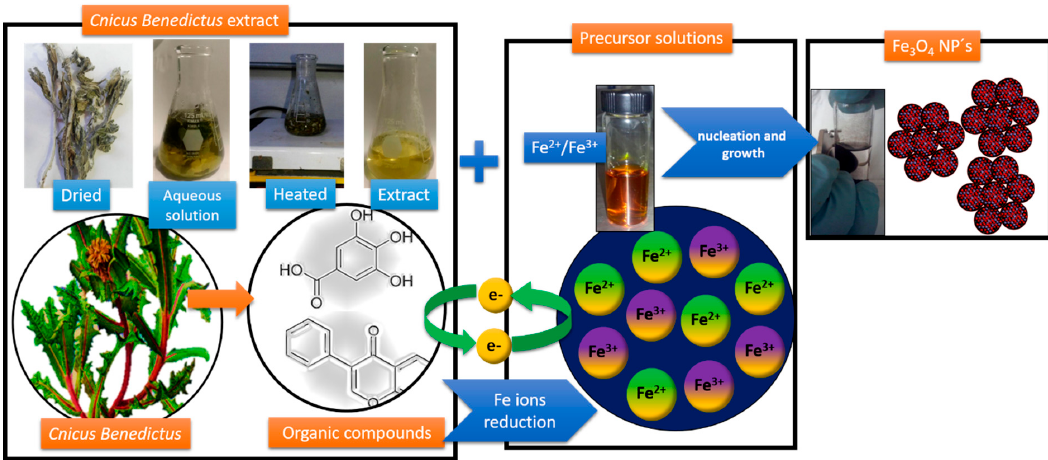
Figure 1. Schematic representation of the green procedure to obtaining Fe 3 O 4 NPs by Cnicus benedictus as reducing agent.